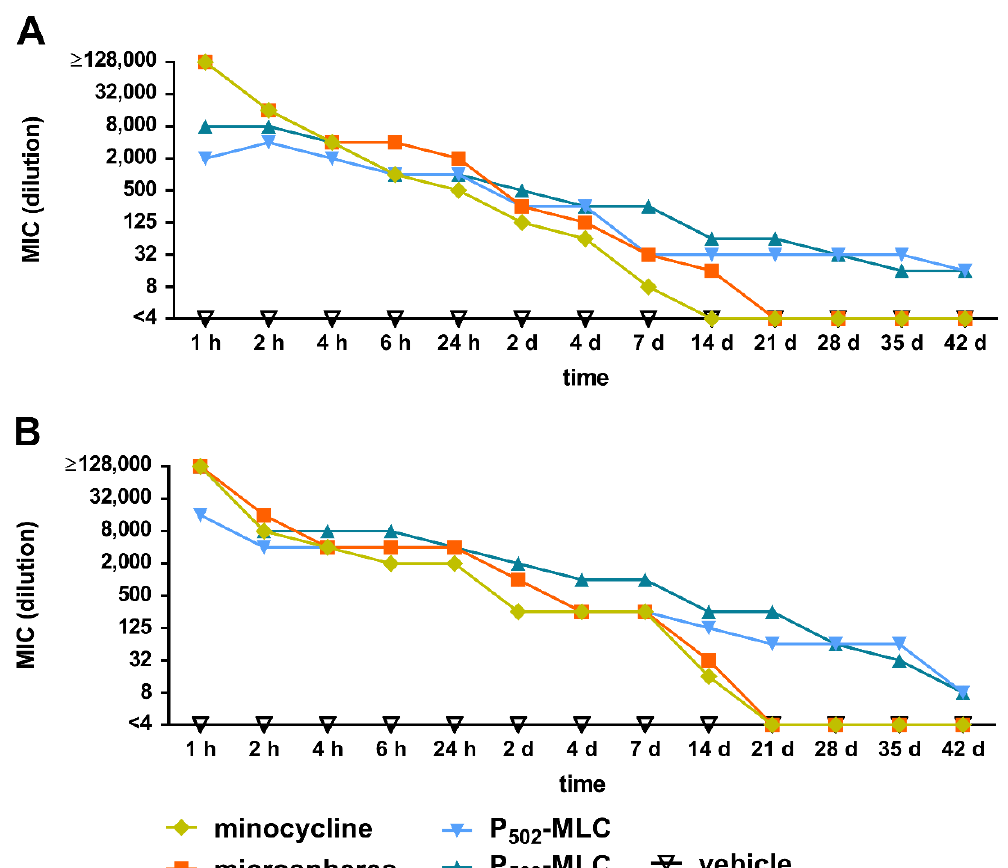
Figure 4. Minimal inhibitory concentration (maximum dilution) of the eluates obtained over a period of 42 days from minocycline formulations (substance (minocycl.) and microspheres (microsph.) polymer-lipid complex extrudate (PLM-C)) and PLM-C without minocycline (vehicle) according to 1 µ g of minocycline and simulating the flow of the gingival fluid against Streptococcus gordonii ATCC 10558 ( A ) and Porphyromonas gingivalis ATCC 33277 ( B